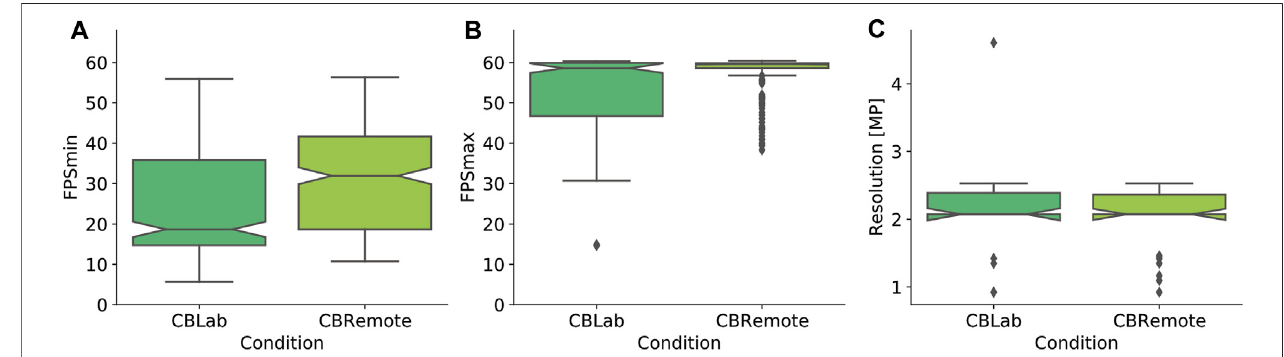
FIGURE3| Hardwareperformanceindicatorsforthesmartphonesusedinthetwotestenvironments. (A) showstheminimumframeratesthatoccurredinthetest runs, and (B) the maximum frame rates achieved. (C) compares the display resolutions.